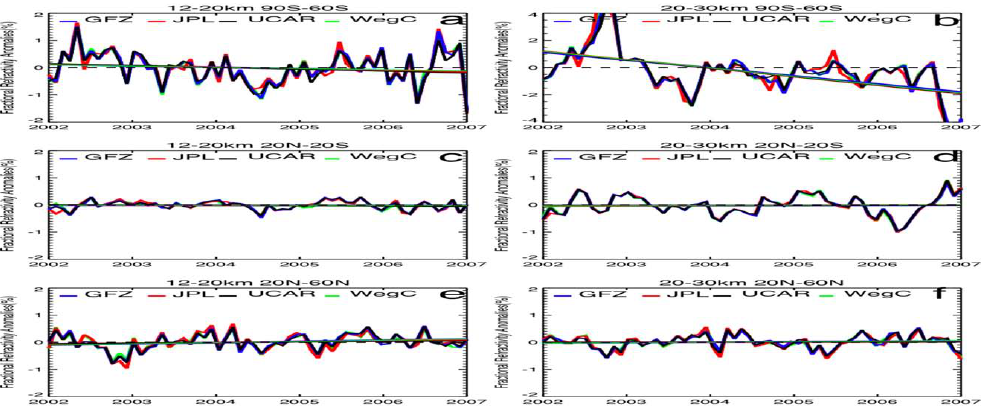
Fig. 32. Comparison of RO data (fractional refractivities) processed by four independent centers, GFZ (GeoForschungsZentrum, Potsdam), JPL, UCAR, and the Wegener Center (WegC) over the period 2002–2007. (a) 12–20km, 90 ◦ –60 ◦ S; (b) 20–30km, 90 ◦ –60 ◦ S; (c) 12–20km,